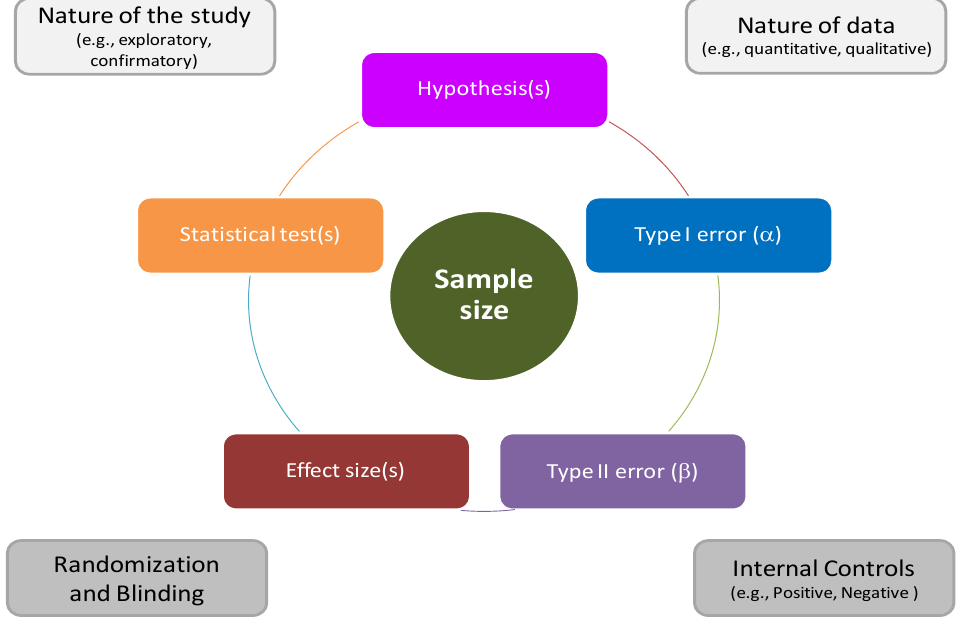
Figure 1. Key statistical – methodological factors to be considered in planning an experiment.